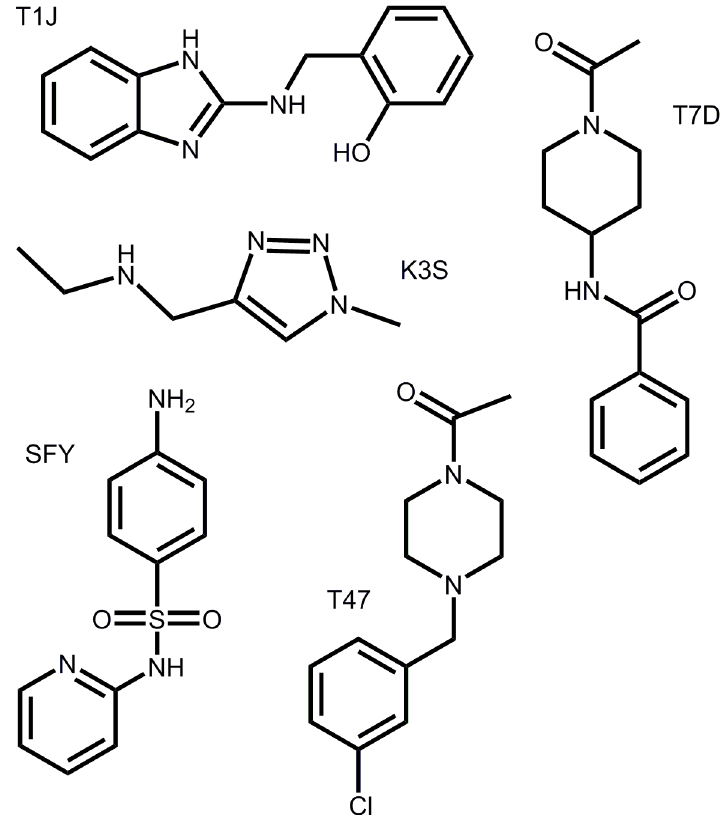
Figure 4. Structures of the five zinc database inhibitors selected as parent structures for further docking